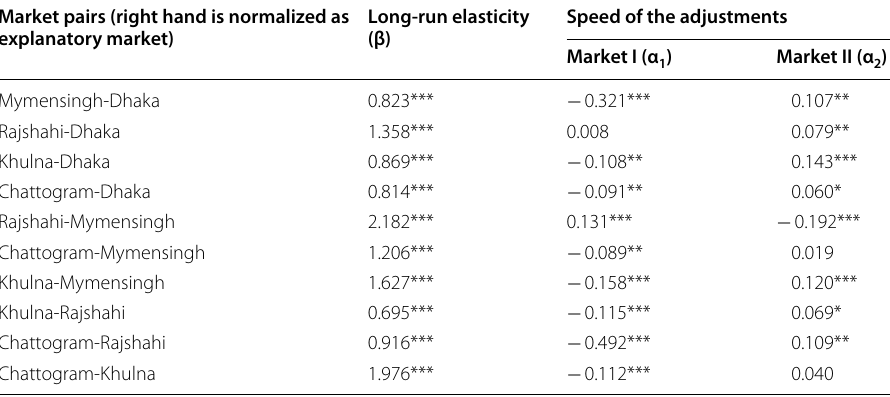
Long-run elasticity Speed of the adjustments (β) Market I (α 1 ) Market II (α 2